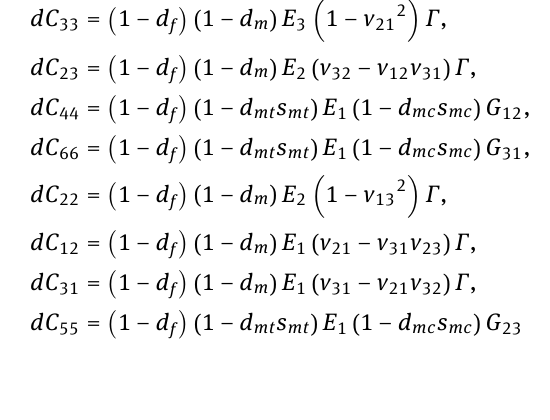
Table 3: Failure criteria Failure mode